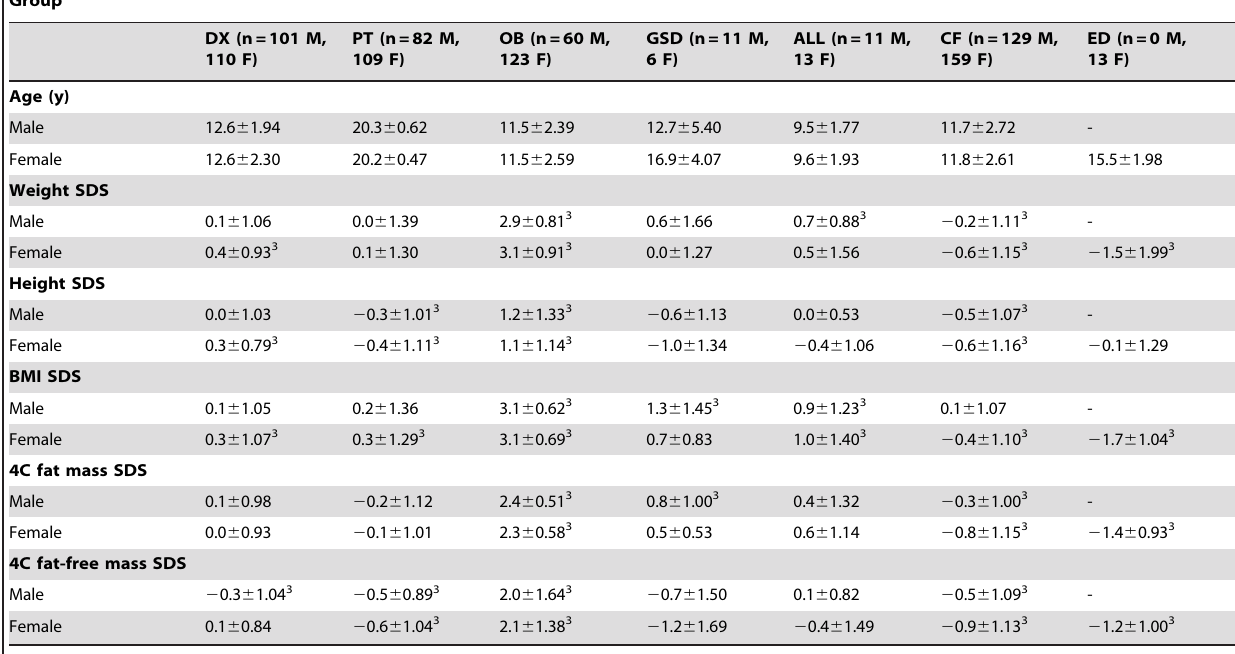
Table 1. Characteristics of the study groups 1,2